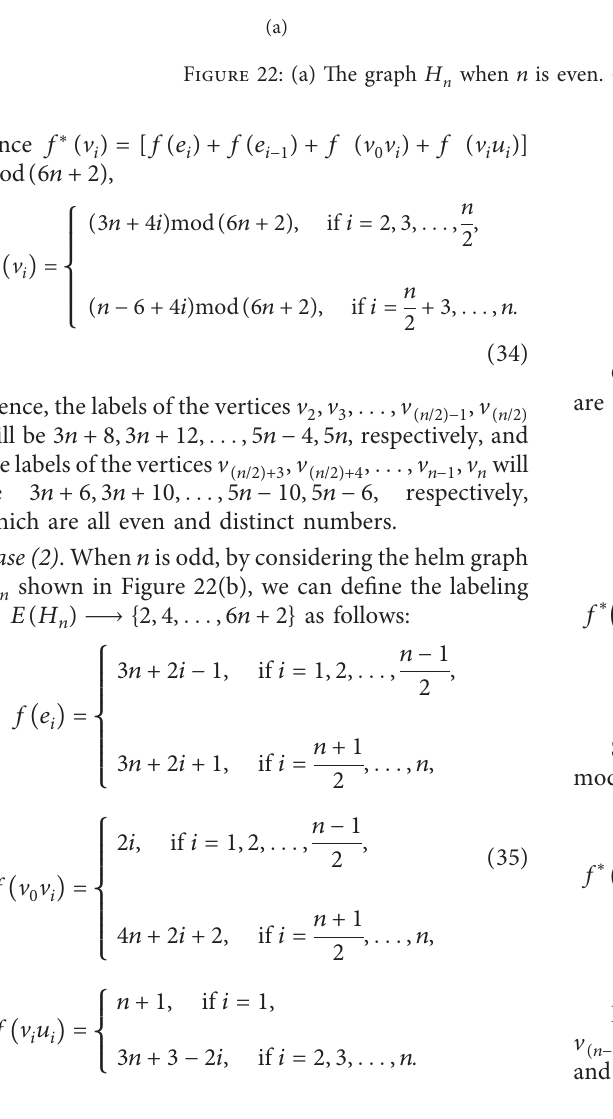
n is even. (b) The graph H n when